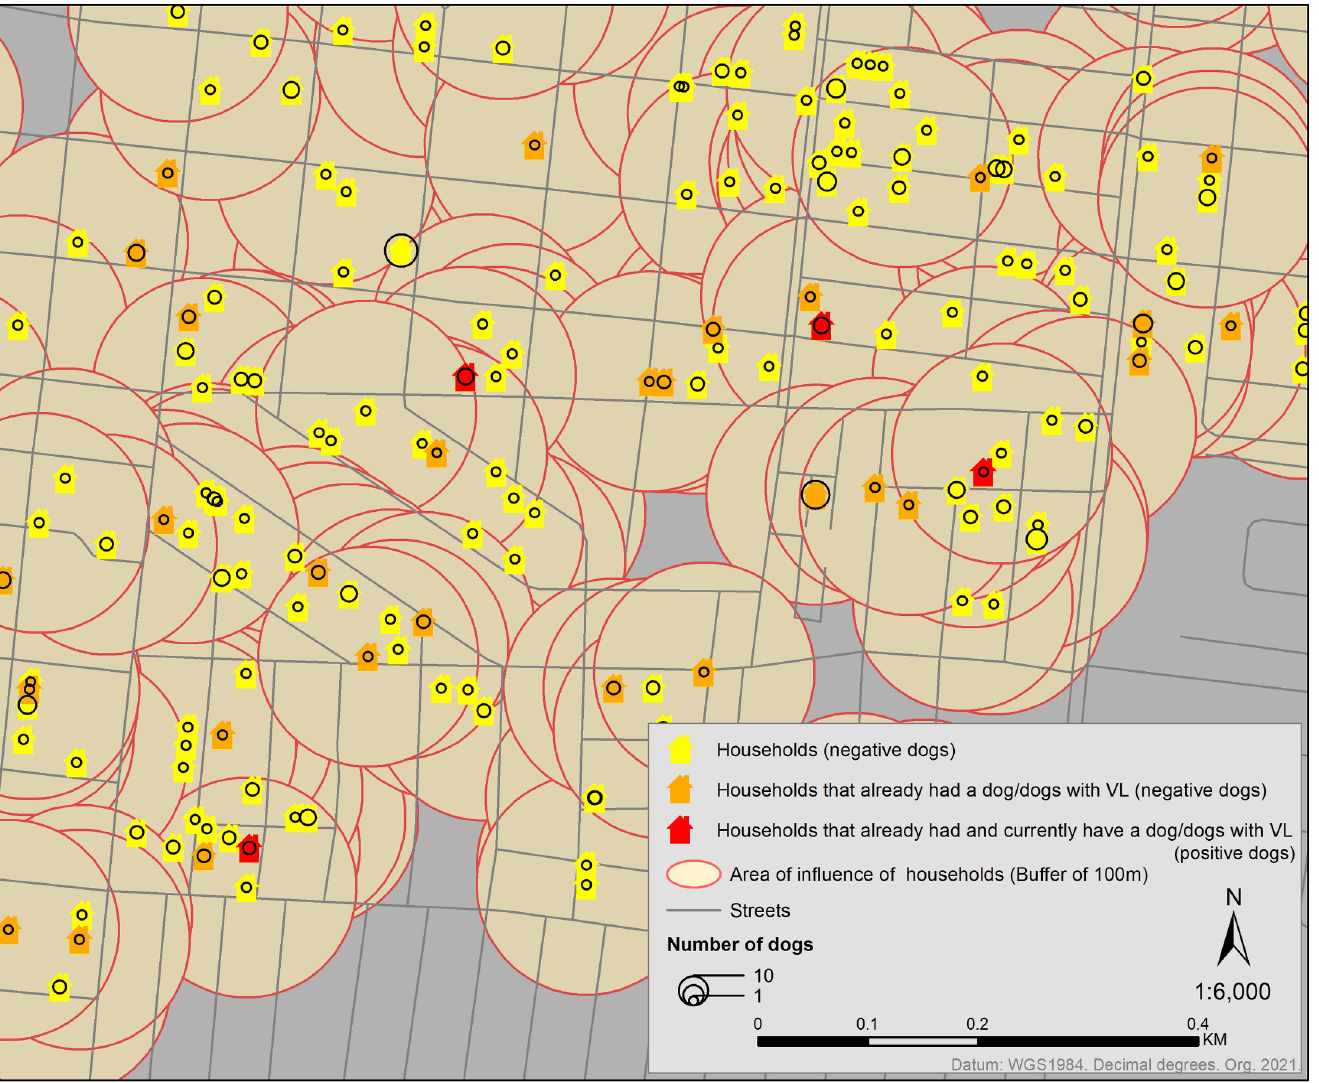
Fig 3. Geocoded households of Bauru, stratified by dog population, positive dogs, and buffer zones. The households are identified according to the conducted surveys. Yellow, orange, or red symbols represent the dog’s households sampled. Yellow had not an infected dog; orange had an infected dog (in the past); red had and currently has an infected dog. Proportional circles represent the number of dogs in each household. We created a buffer of 100m in each sampled household to calculate the number of dogs, positive or negative dogs in this area.